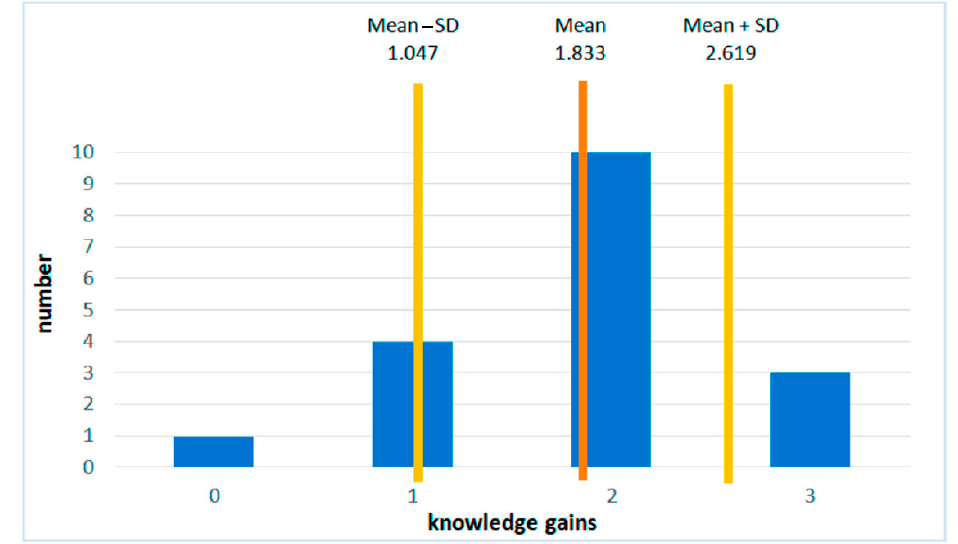
Figure 6. Histogram of gains in knowledge by self-assessment by the learners.